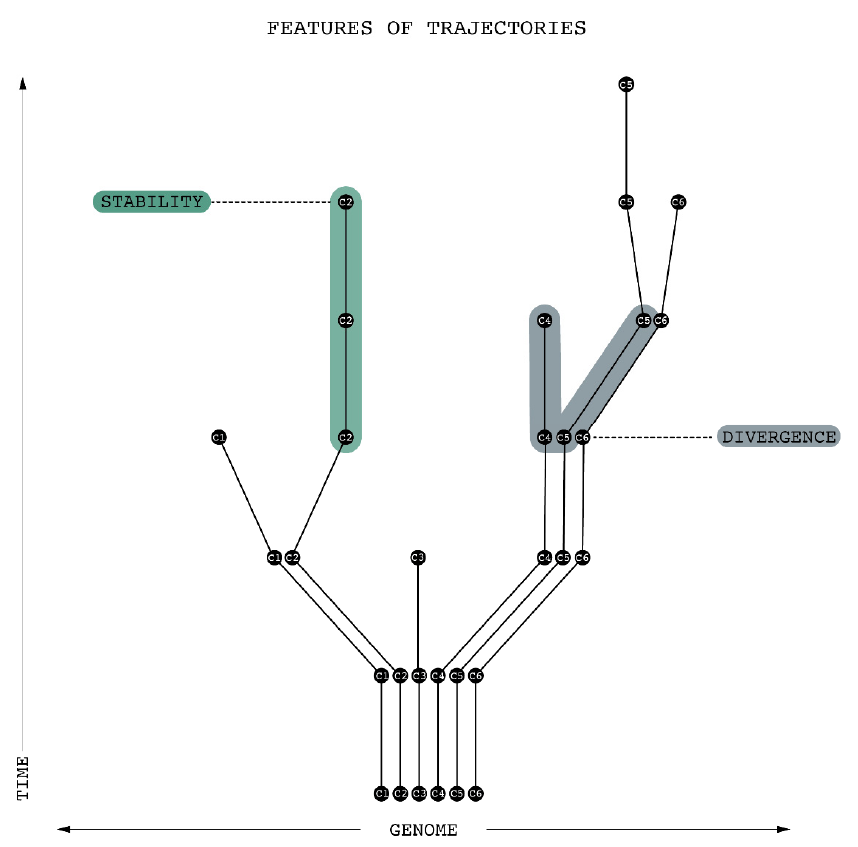
Figure 6. Urban Genome Trajectories—each trajectory is a separate c.